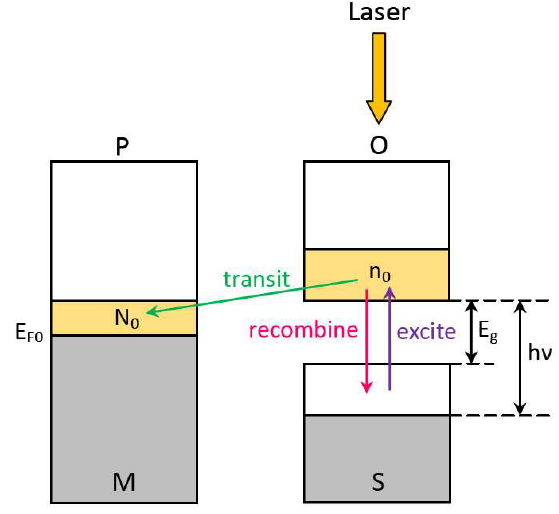
Figure 11. Diagram of electron transition from semiconductor to metal induced by laser illumination. The gray parts and the yellow parts represent the original equilibrium electrons and the laser-induced non-equilibrium electrons,